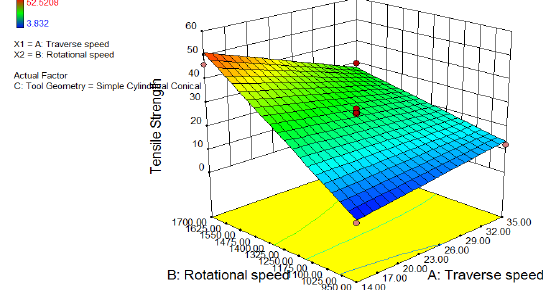
Fig. 11: 3D-Graph Interaction of Traverse vs Rotational Speed for Tensile Strength with a Threaded Cylindrical Tool